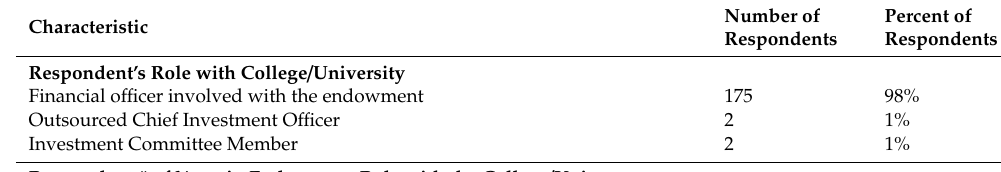
Table 2. Demographic Profiles of Respondents and Their